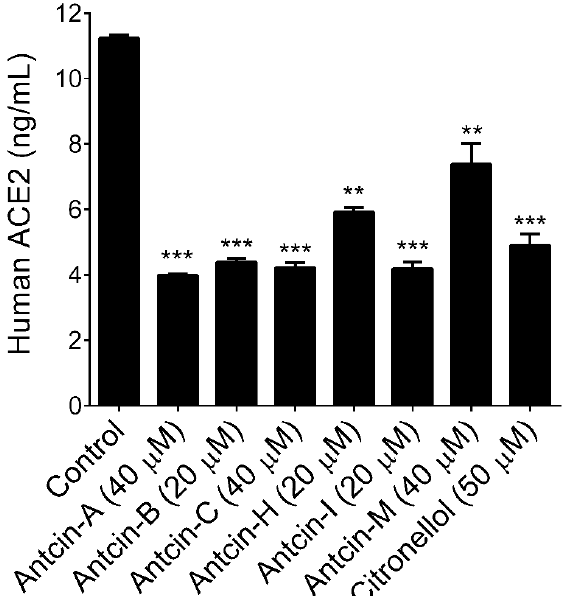
Figure 3. Antcins reduced human ACE2 levels in HT-29 cells. HT-29 cells were incubated with the indicated concentration of antcins for 48 h. Cell lysates were subjected to determine ACE2 levels using a commercially available ELISA kit. Values represent the mean ± SD of three independent experiments. p -values of less than 0.01 **, and 0.001 *** were considered statistically significant for the antcins treatment group vs. the control